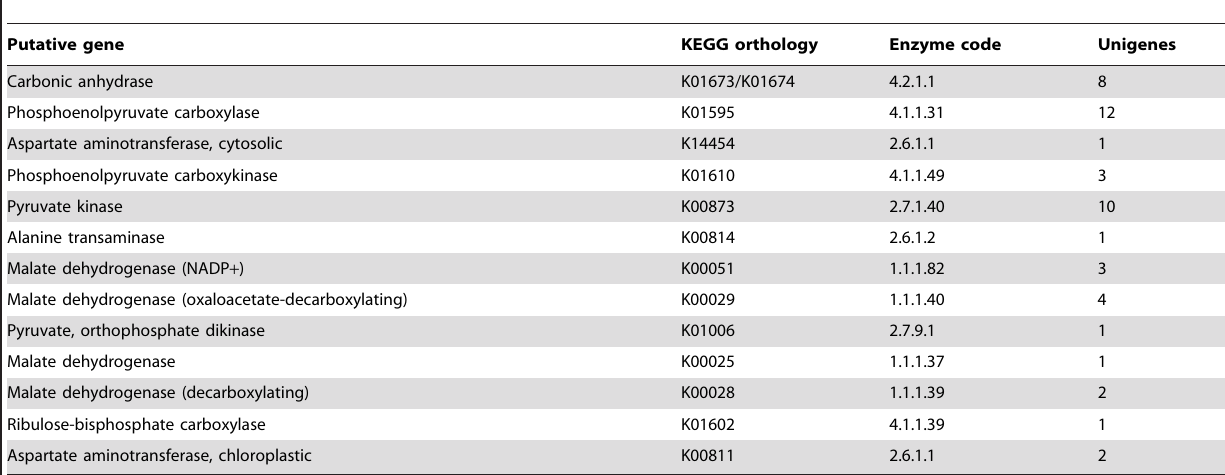
Table 4. List of genes comprising the C 4 photosynthetic pathway found among P. maximum unigenes.